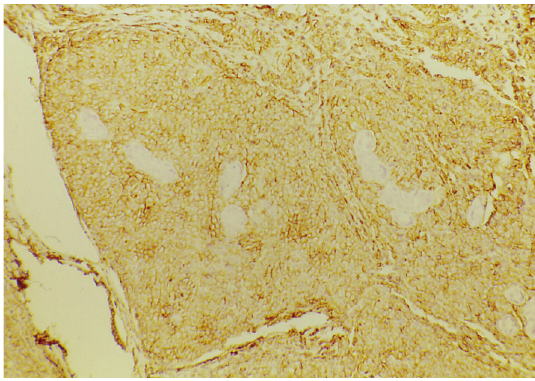
Figure 3: CD34: intense positive